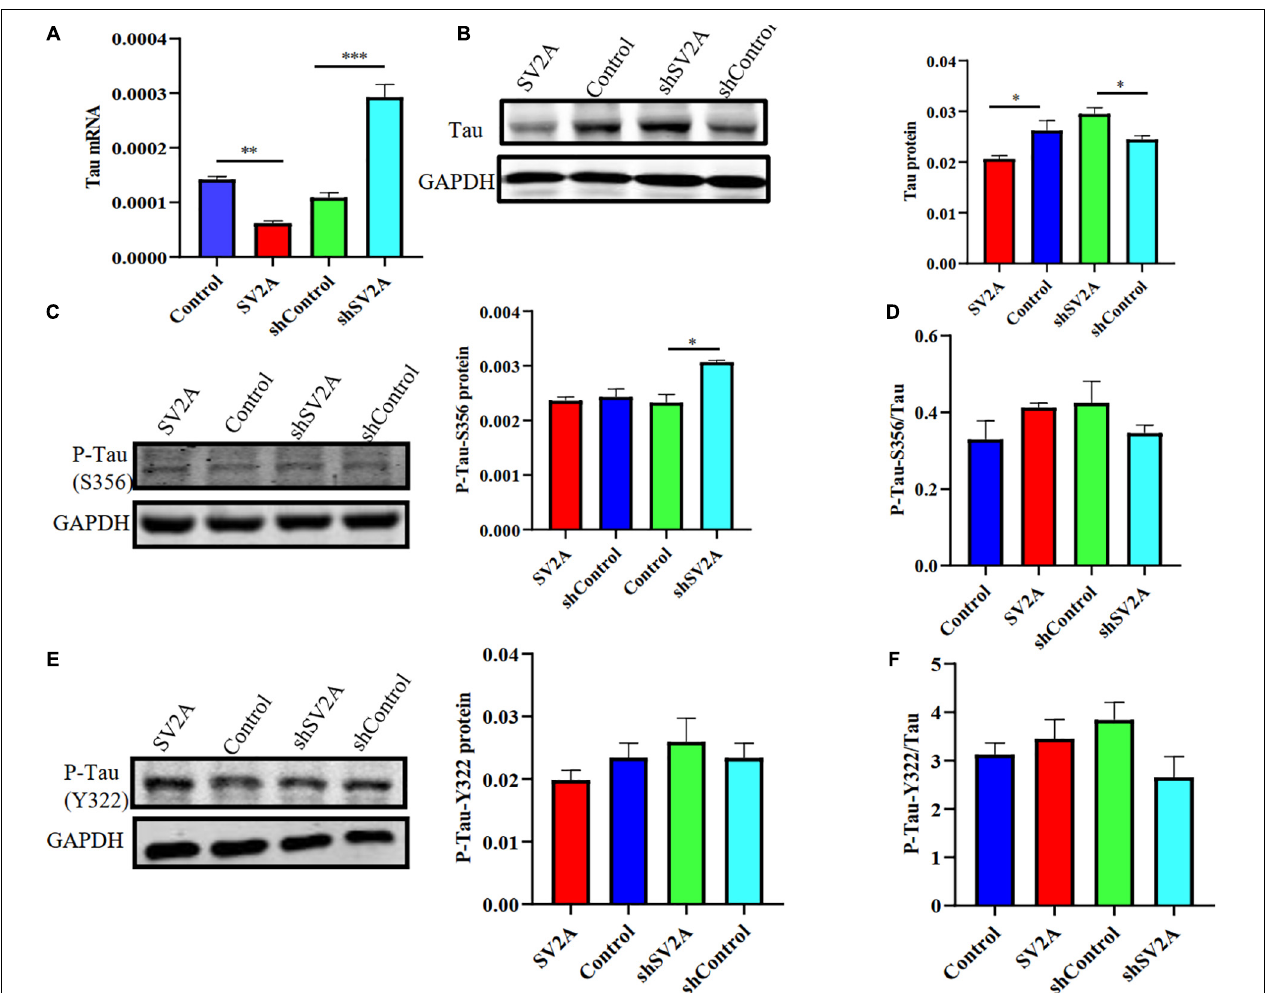
FIGURE 4 | SV2A deficiency promotes tau hyperphosphorylation. (A) qPCR detection of the tau mRNA expression level in APPswe293T cells from the following four groups: control, cells infected with the SV2A-overexpressing virus (SV2A), shControl, and cells infected with the SV2A-silencing virus (shSV2A). Gapdh was used as the internal control. (B) Western blotting detection of tau expression levels in APPswe293T cells from the following four groups: control, cells infected with the SV2A-overexpressing virus (SV2A), shControl, and cells infected with the SV2A-silencing virus (shSV2A). The gray density was normalized to the mean gray density of Gapdh. (C) Western blotting detection of P-Tau-S356 protein (phosphorylated tau protein mutated at serine 356) expression levels in APPswe293T cells from the following four groups: control, cells infected with the SV2A-overexpressing virus (SV2A), shControl, and cells infected with the SV2A-silencing virus (shSV2A). The gray density was normalized to the mean gray density of Gapdh. (D) Ratio of P-Tau-S356 and tau protein expression levels in APPswe293T cells from the following four groups: control, cells infected with the SV2A-overexpressing virus (SV2A), shControl, and cells infected with the SV2A-silencing virus (shSV2A). The gray density was normalized to the mean gray density of Gapdh. (E) Western blotting detection of the P-Tau-Y322 protein (phosphorylated tau protein mutated at tyrosine 322) expression levels in APPswe293T cells from the following four groups: control, cells infected with the SV2A-overexpressing virus (SV2A), shControl, and cells infected with the SV2A-silencing virus (shSV2A). The gray density was normalized to the mean gray density of Gapdh. (F) Ratio of P-Tau-Y322 and tau protein expression levels in APPswe293T cells from the following four groups: control, cells infected with the SV2A-overexpressing virus (SV2A), shControl, and cells infected with the SV2A-silencing virus (shSV2A). The gray density was normalized to the mean gray density of Gapdh. For each group of APPswe293T cells, n = 3. Data are expressed as mean ± SEM. One-way analysis of variance (ANOVA). * P < 0.05, ** P < 0.01, *** P <